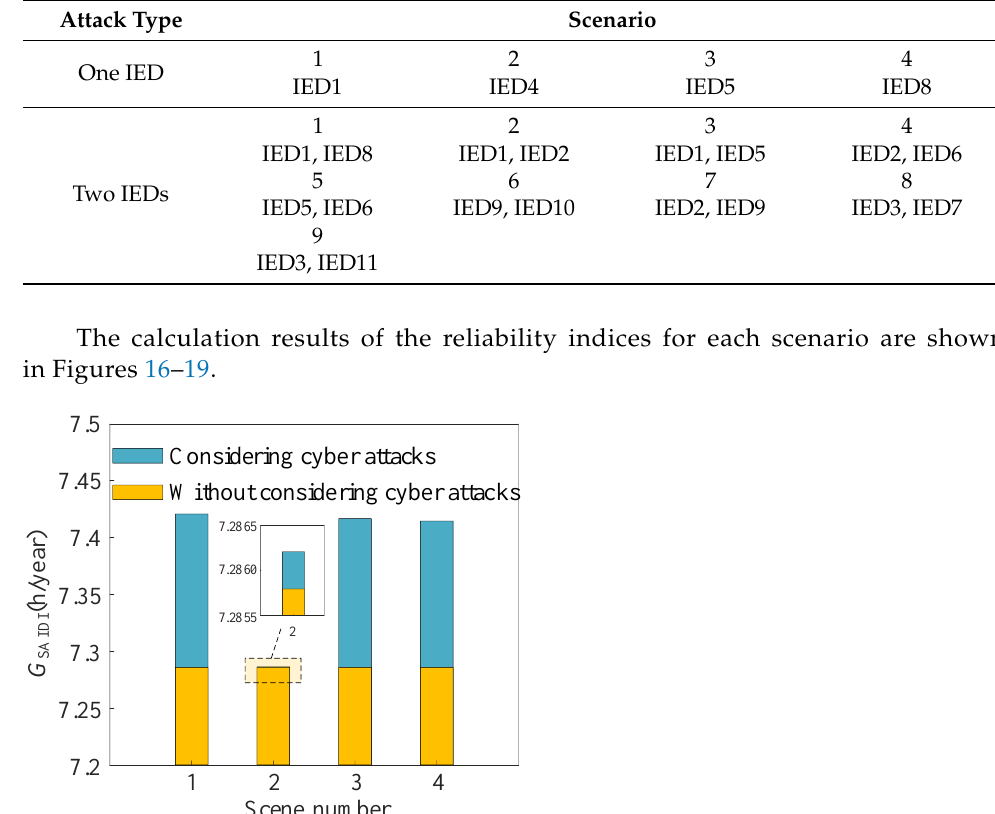
Figure 16. Impact of attacking one IED on G SAIDI .